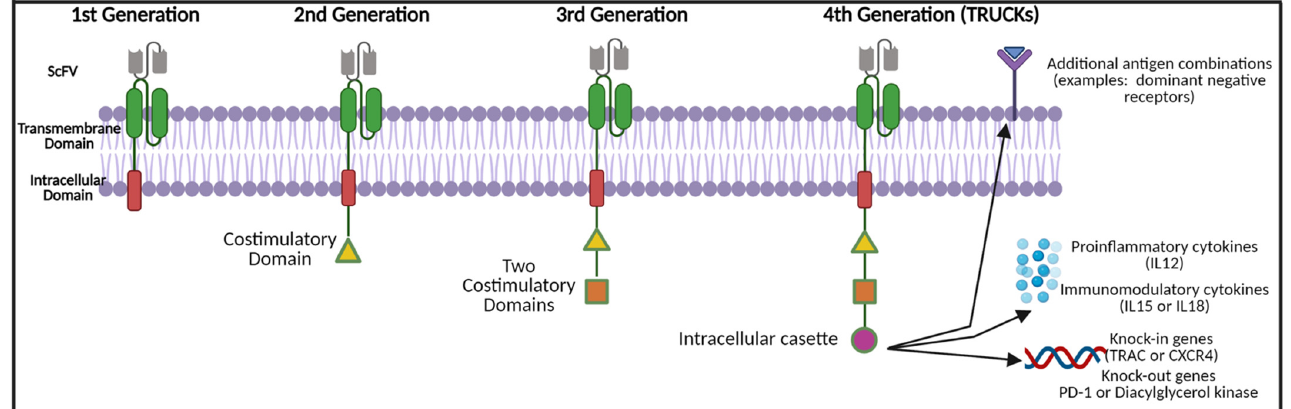
Figure 2. CAR-T cell modifications and evolution throughout generations. Abbreviations: ScFV— single chain variable fragment; IL—interleukin; TRUCKS: T-cells redirected for universal cytokine mediated killing; TRAC—T-cell receptor α constant, CXCR4—chemokine receptor type 4; PD-1— programmed death cell protein 1. Created with BioRender.com (accessed on 1 December 2021).